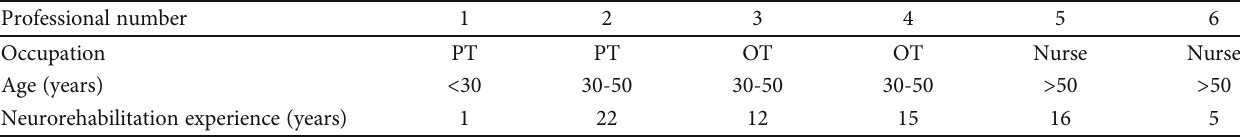
Table 4: Characteristics of the health professionals included in interview.